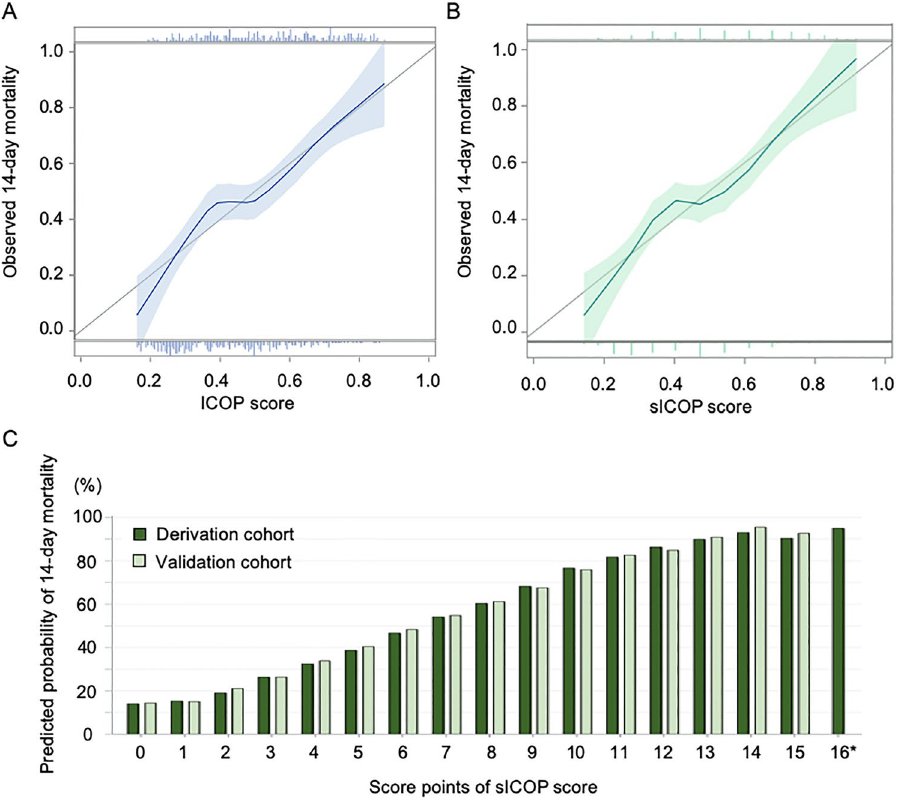
Figure 4. Calibration plots in validation cohort of ICOP score/sICOP and predicted probability of 14-day mortality by each point on sICOP. Calibration plots of our predictive scores (ICOP score and sICOP) for 14-day mortality after intubation ( A , B ). The calibration curves represent the relationship between the mortality predicted by the ICOP score (x-axis) and the observed mortality (y-axis). The gray lines in figures represent a perfect calibration. A calibration curve below the gray line indicates that the score overestimates the mortality. ( C ) Predicted probability of 14-days mortality after intubation by each score point on sICOP (0–16 points). *There were no patients who scored 16 points on sICOP in the validation